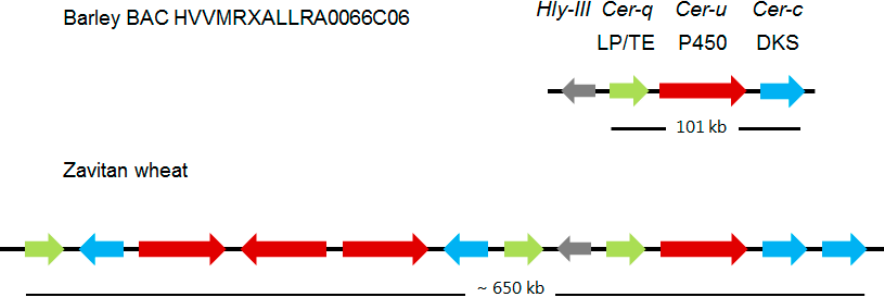
Figure 3. Comparison of the Cer-cqu gene clusters encoding wax β -diketone polyketides in barley and wheat. The latter cluster has undergone numerous duplication events since these species diverged. Only the 11 of the 15 Zavitan genes with potential function having homology to the Cer-c (blue), - q (green), and -u (red) genes of the barley cluster are shown. Those with highest homology to the barley genes are aligned vertically although the two DKS sequences at the right end of the wheat cluster cannot be discriminated between on this basis. Albeit associated with both clusters the Hyl-lll gene does not participate in polyketide biosynthesis. LP/TE, lipase/thioesterase; DKS, diketone synthase; P450, cytochrome P450 enzyme. Broad arrows represent relative lengths of the specified barley MLOCs and amount to only 5.3 kb of the 101 kb long cluster. Derived from [26] and [27].